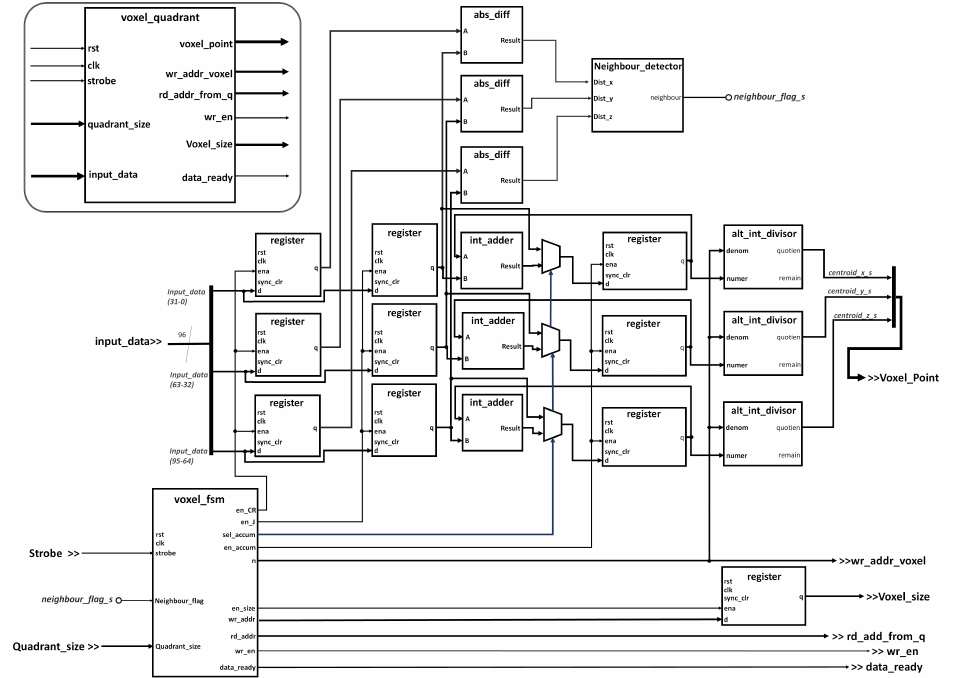
Figure 8. Internal architecture of the voxel quadrant module.